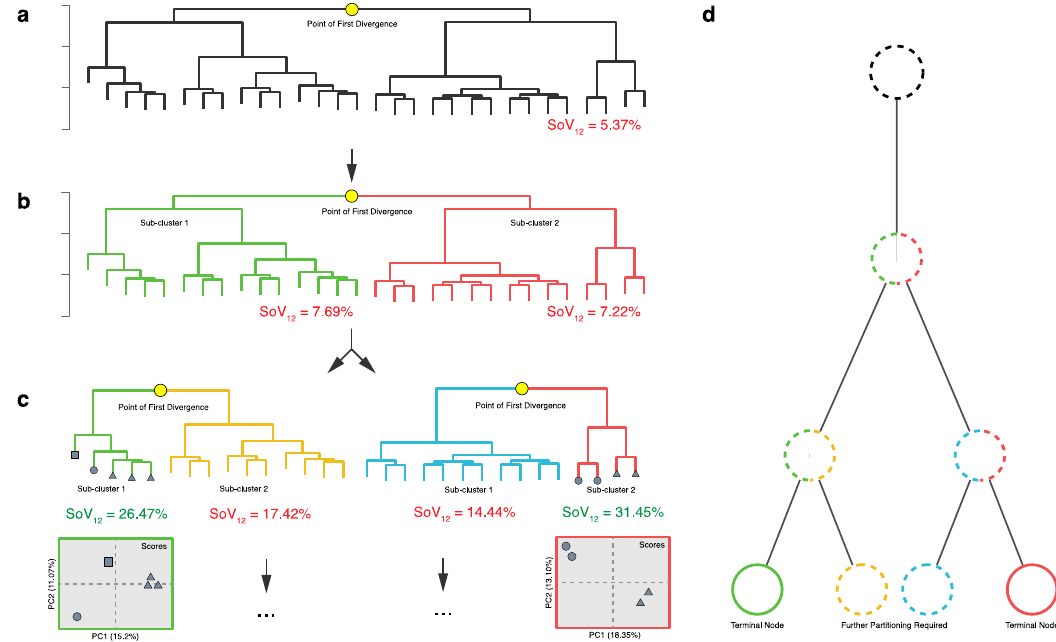
Figure 3. Scheme depicting hcapca logic. Note also that a small (35 sample) example of the walk through of hcapca processing and interactive visualization is depicted in Supplementary Information Figures S4–S13. ( a ) The first tree is partitioned into two smaller sub-clusters. ( b ) Since the SoV 12 for the two sub-clusters does not meet the cutoff value (25%), they are further split into smaller groups ( c ). The SoV 12 of the red and green clusters is more than the cuto ff value and so their partitioning stops and PCA models are made (red/green squares). The green and blue sub-clusters have SoV 12 s lower than the cutoff so they are split further as indicated by the ellipsis. ( d ) The overall structure of this schema results in a “tree-of-trees”. The circles represent the various nodes being formed and are colored as per the trees (from a, b, and c) that they represent. Dashed borders indicate nodes that need to be partitioned further while solid lines denote nodes that can no longer be split.